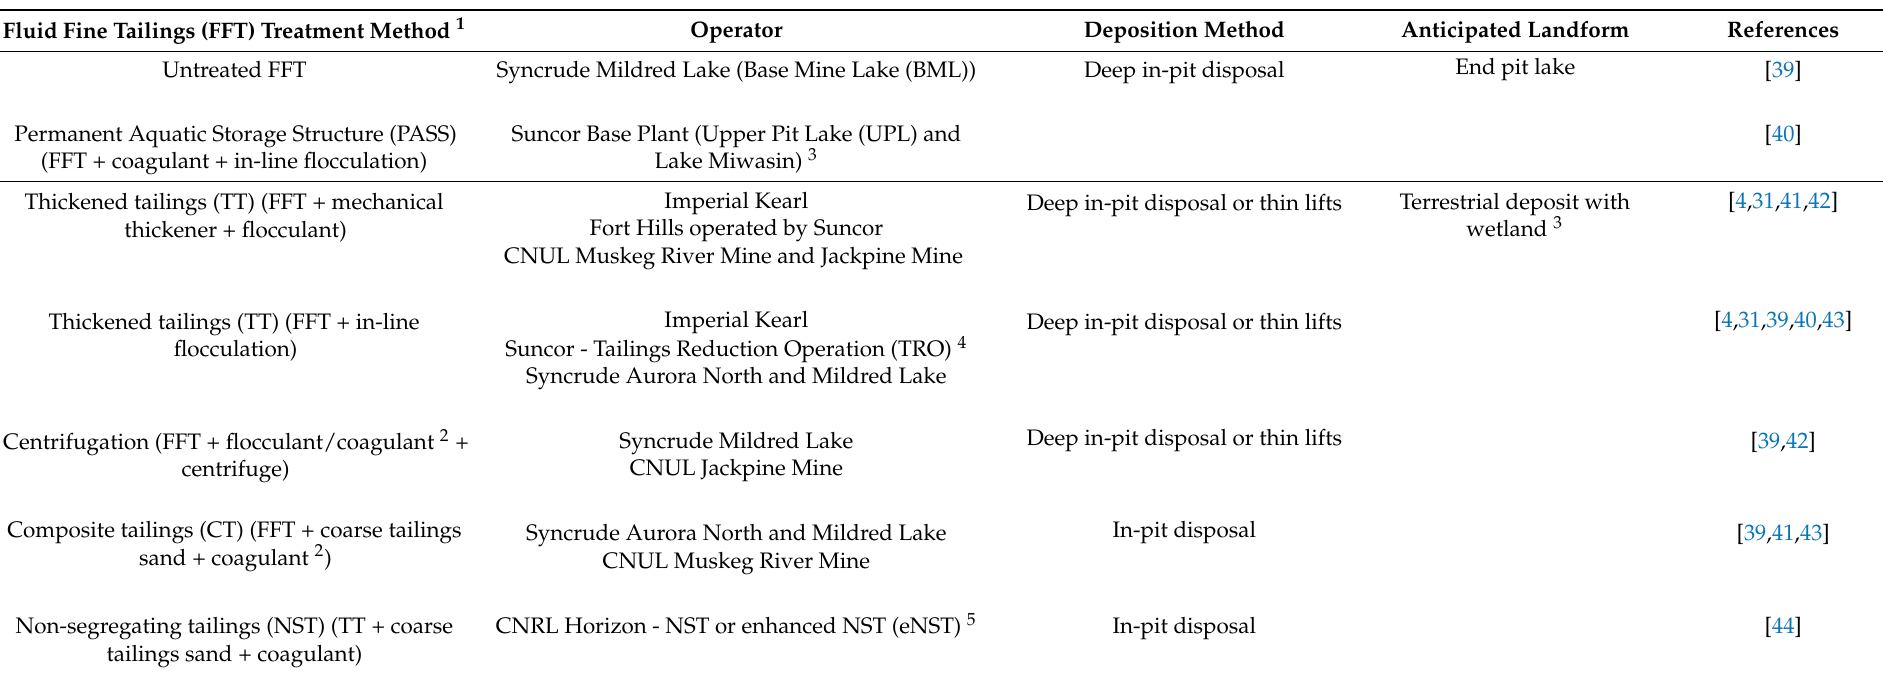
Table 1. Summary of oil sands fluid fine tailings treatment methods used by Canadian Natural Resources Ltd. (CNRL), Canadian Natural Upgrading Ltd. (CNUL), Imperial, Suncor, and Syncrude, as well as the associated deposition method and anticipated